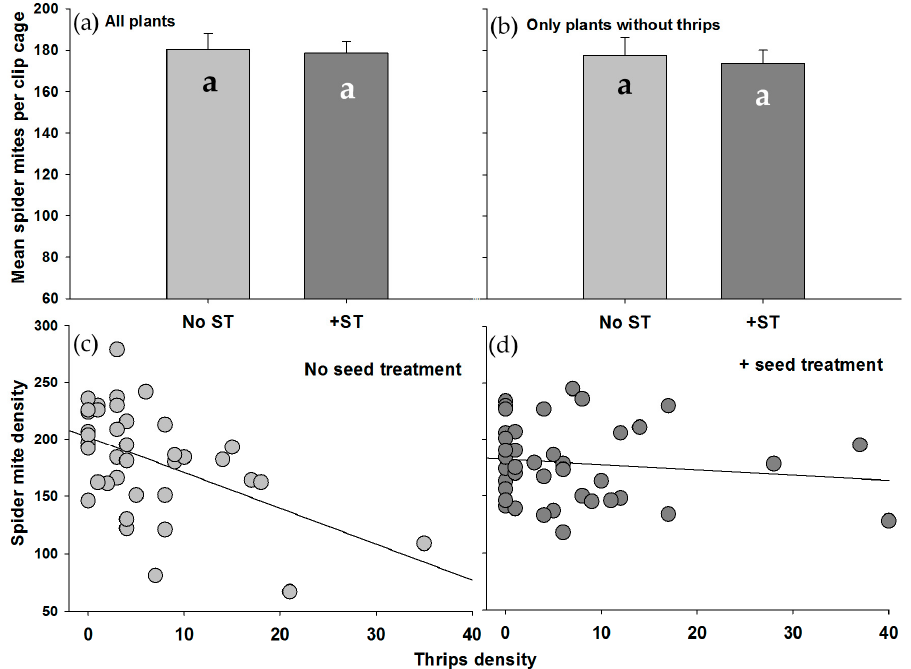
Figure 1. Mean arthropod density (±SE) per clip cage at the end of an 8 day greenhouse